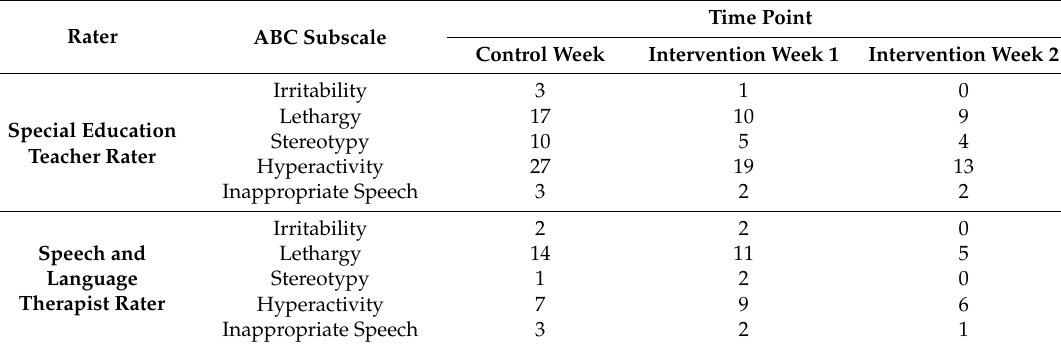
Table 5. Efficacy stage ABC subscale scores for Participant